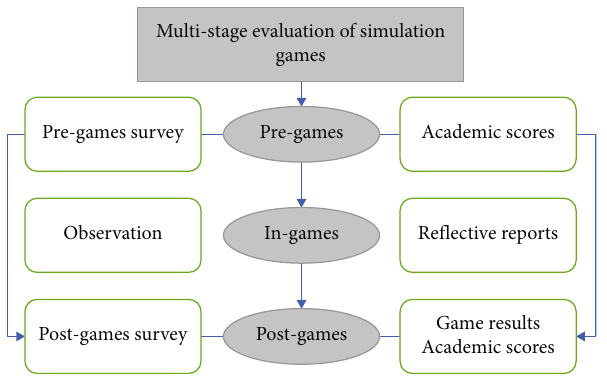
Figure 13: Evaluation methods at di ff erent stages of